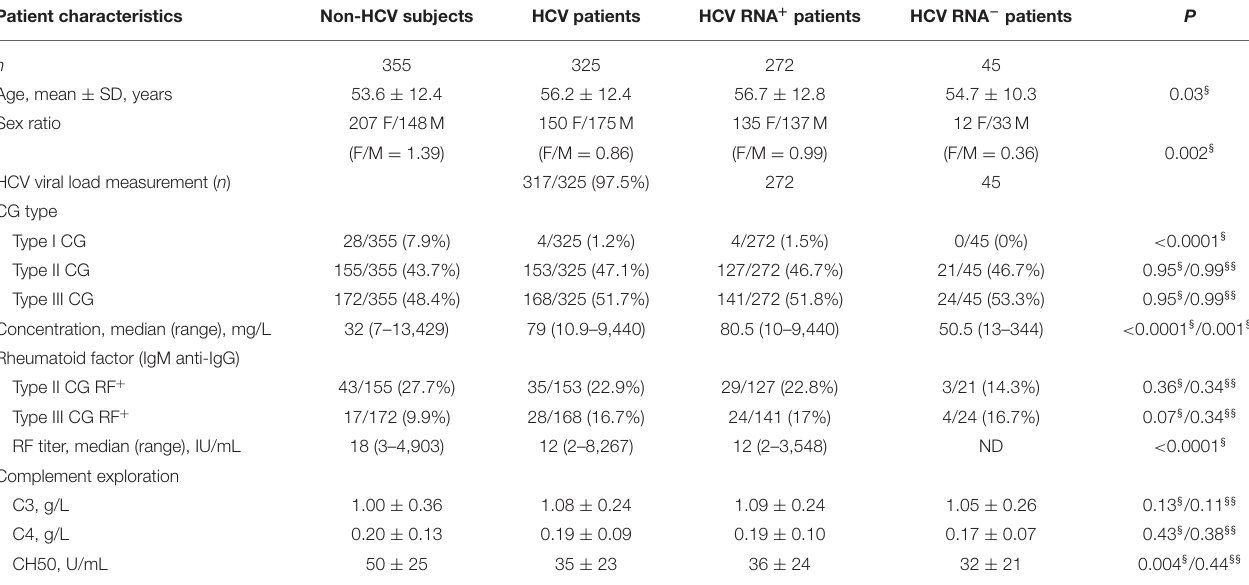
TABLE 1 | Demographic, HCV status, and CG characteristics of included patients.